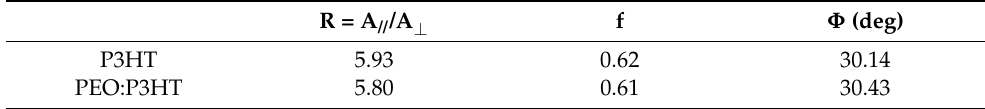
Table 2. Observed IR dichroic ratio for the IR band A (antisymmetric C=C stretching) of P3HT in the two macroscopically oriented fibres of P3HT and of the blend P3H:PEO. The Hermans function f and the average tilting angle ( Φ ) provide an estimate of the degree of molecular orientation of the P3HT chains along the fibre